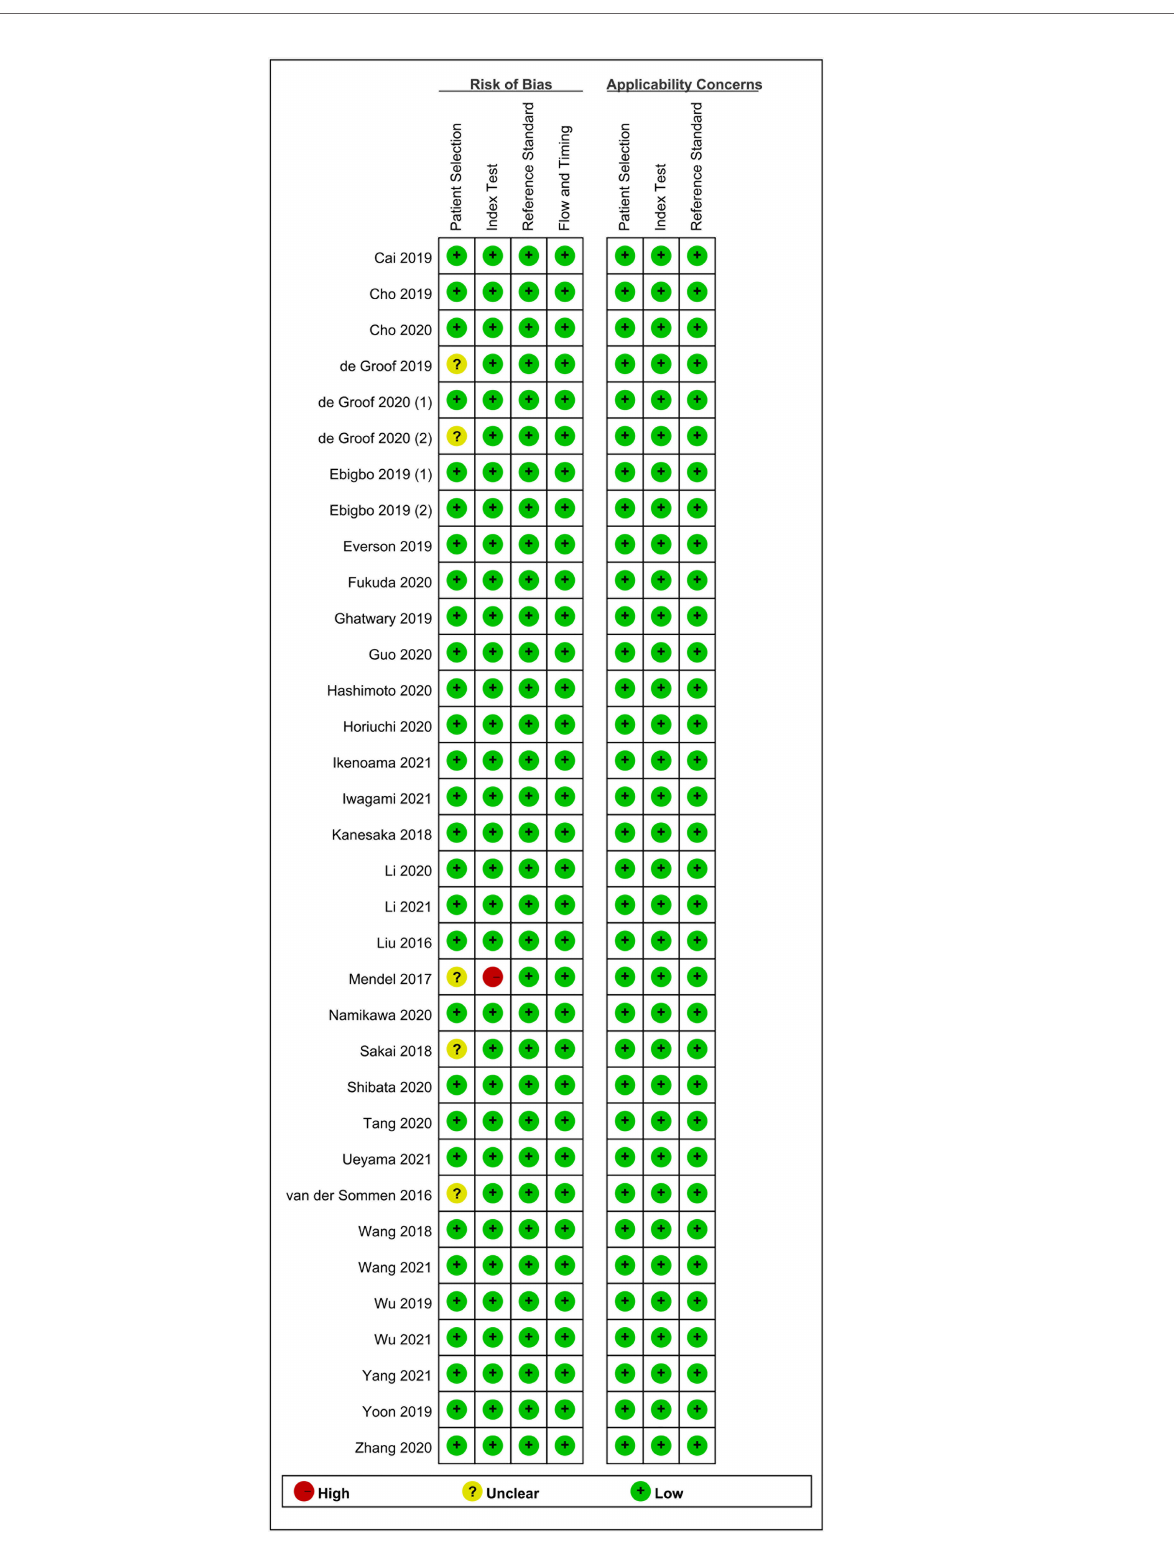
FIGURE 2 | The quality assessment and risk of bias for each eligible